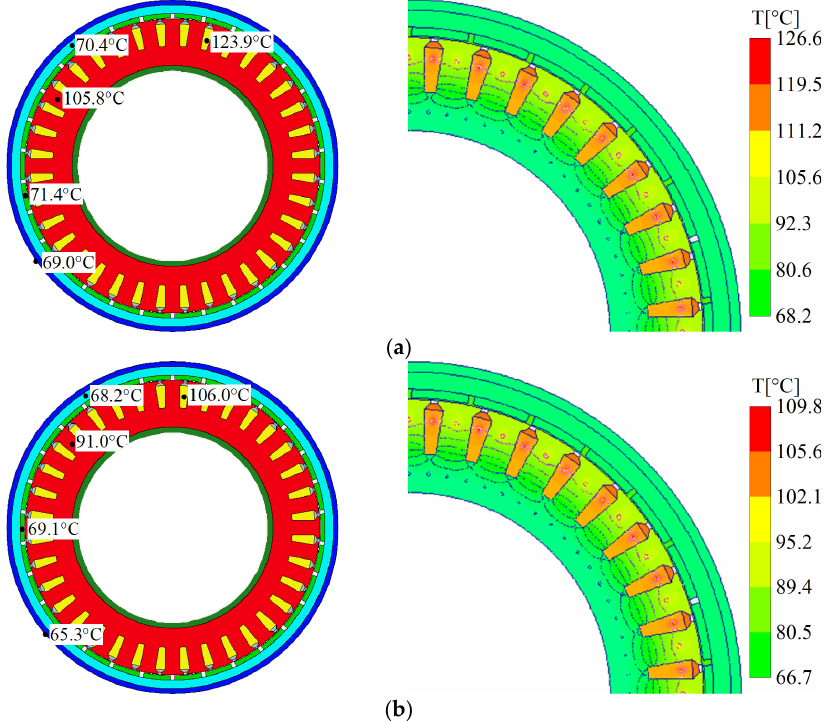
Figure 16. Temperature distribution map of initial and optimization. ( a ) Temperature distribution map of the initial; ( b ) temperature distribution map of the optimization. Table 5. Comparison of initial and optimized performance.